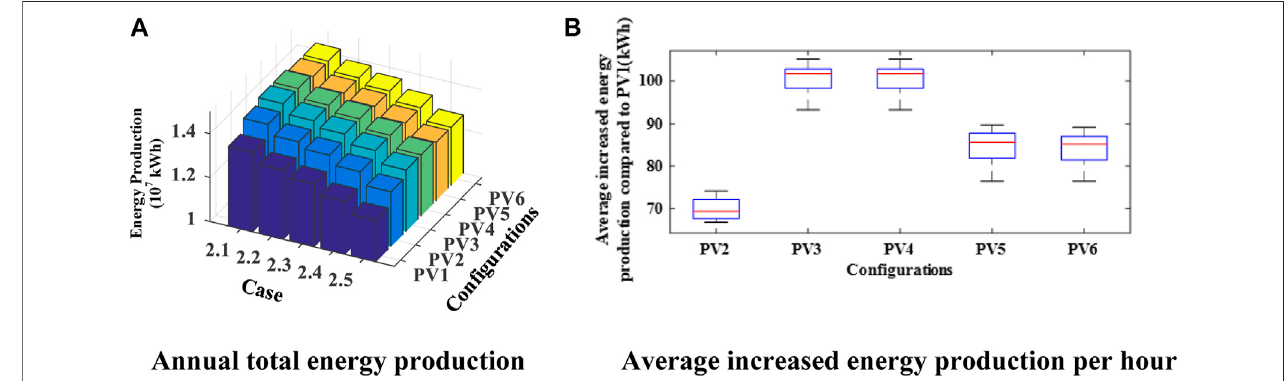
FIGURE 11 | Comparison of fi ve cases for the geographical location settings. (A) Annual total energy production. (B) Average increased energy production per hour.